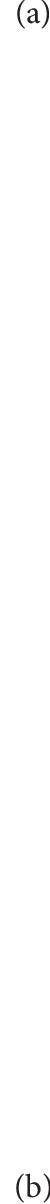
Verrucous Carcinoma. Marked digitated acanthosis of is associated with bulbous aggregates of squamous epithelium, producing a pushing border. Cytologic atypia was minimal. A focus of SCAP is present at the lower left 20x.